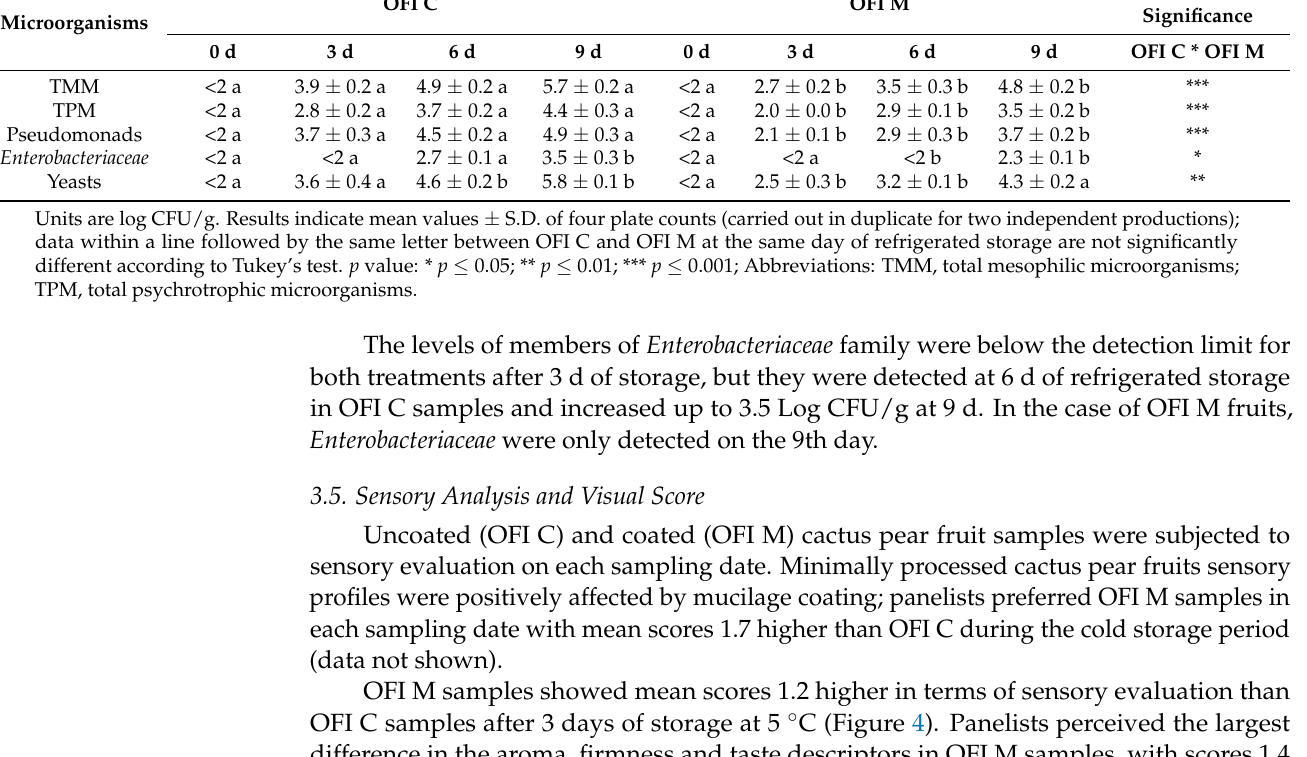
Table 3. Microbial loads of minimally processed uncoated O. ficus-indica (OFI C) and coated (OFI M) fruits during cold storage (9 days at 5 ◦ C).